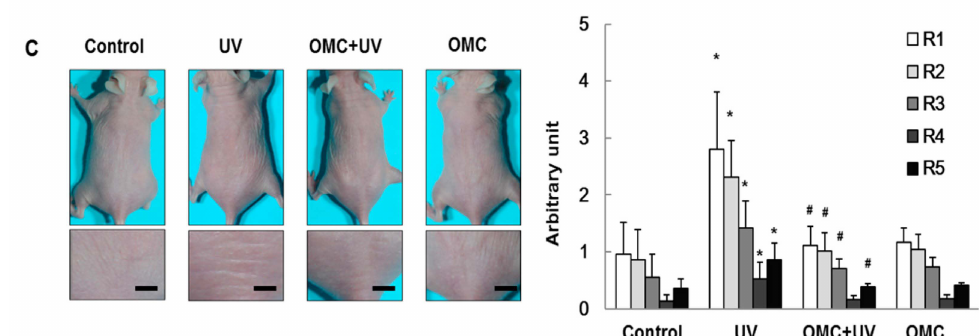
Figure 5. Effects of OMC on Survivin and Daxx expression in the skin of UV-irradiated SKH-1 hairless mice. Immunoblotting results showed that UV-induced upregulation of ( A ) Survivin and ( B ) Daxx was inhibited by OMC. Scale bar = 20 µ m; ( C ) Effects of OMC on wrinkle formation in UV-irradiated SKH-1 hairless mice. Representative photographs show wrinkles of rats in the control, UV, OMC + UV, and OMC groups. Scale bar = 5 mm. UV irradiation increased the values of R1, R2, R3, R4, and R5. OMC treatment inhibited wrinkle formation in the OMC + UV group; * p < 0.05 vs. control and # p < 0.05 vs. UV (two-way ANOVA followed by Bonferroni post-hoc